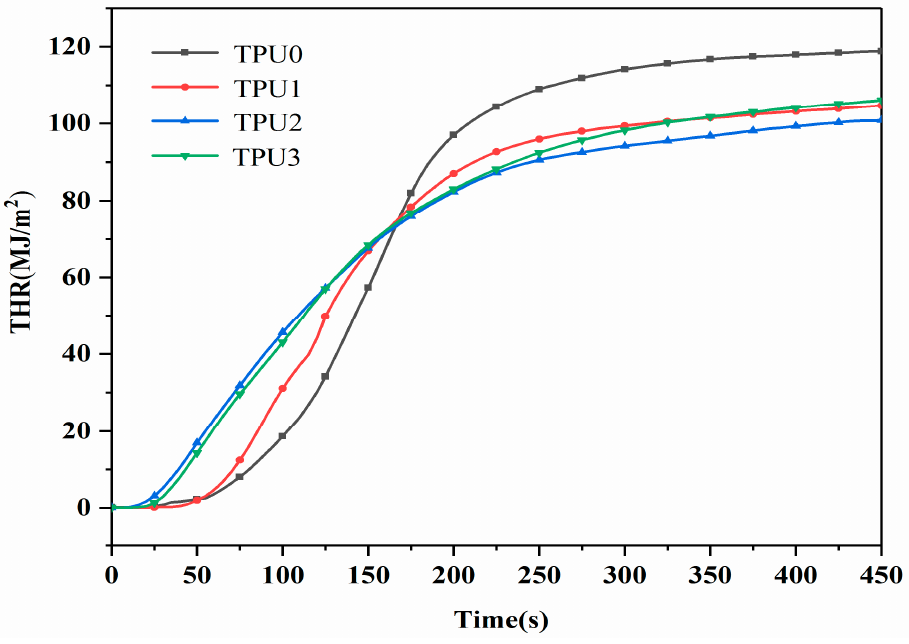
Figure 7. Total heat release curves of TPU composites. The amount of heavy smoke released during the combustion process is an important parameter to evaluate the fire hazard of TPU. The SPR (smoke production rate) curves of pure TPU and its composites are shown in Figure 8. The PSPR (peak smoke production rate) value of pure TPU reaches 0.113 m 2 /s, indicating the highest smoke emission. Nevertheless, the addition of MoS 2 has little effect on the PSPR value of the TPU composite, indicating that MoS 2 alone could not achieve satisfactory smoke suppression effect. In contrast, the PSPR value of NiCo-LDH filled TPU2 is further reduced to 0.056 m 2 /s, which is reduced by 50.4% as compared to that of pure TPU. It is ascribed that the transition metals Ni and Co have the effect of catalytic carbonization, and the formed carbon layer can reduce the combustible gas and smoke-forming materials in the gas phase. In addition, the porous structure of 3D hollow NiCo-LDH can absorb organic volatiles generated by the thermal decomposition of TPU, which are the main source of smoke particles [34]. When TPU composite is reinforced with NiCo-LDH/MoS 2 hybrid material, its PSPR value is further reduced to 0.05 m 2 /s, clearly revealing the significant enhancement of smoke suppression performance of TPU composites. This is mainly attributed to NiCo-LDH and MoS 2 decomposed nickel, cobalt and molybdenum compounds can catalyze the formation of carbon, which can suppress the smoke production rate of TPU composites